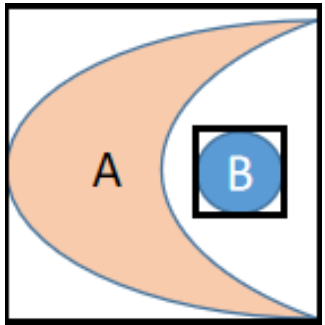
Figure 3 . The minimum bounding rectangle of two polygons intersects, but the polygons do not intersect.